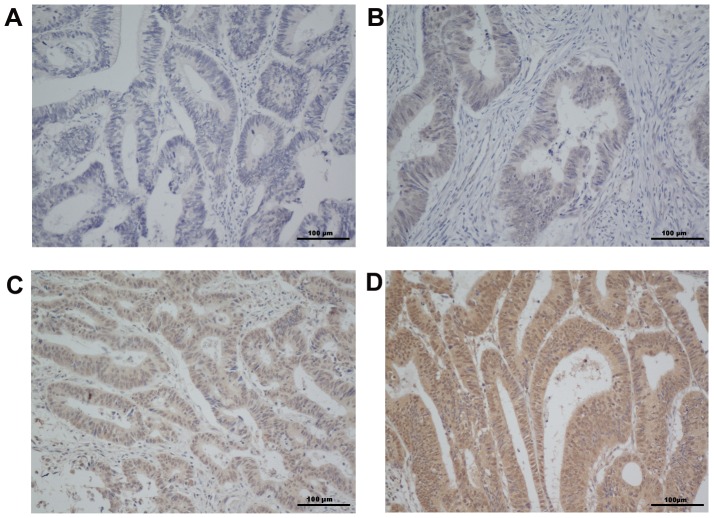
The expression of Cry1 protein in colorectal cancer sections.Representative immunohistochemical images of colorectal cancer tissue specimens indicating negative or weakly detectable Cry1 staining (A and B); moderate Cry1 staining (C); and strong Cry1 staining (D) are shown. Magnification is ×200 (A, B, C and D).